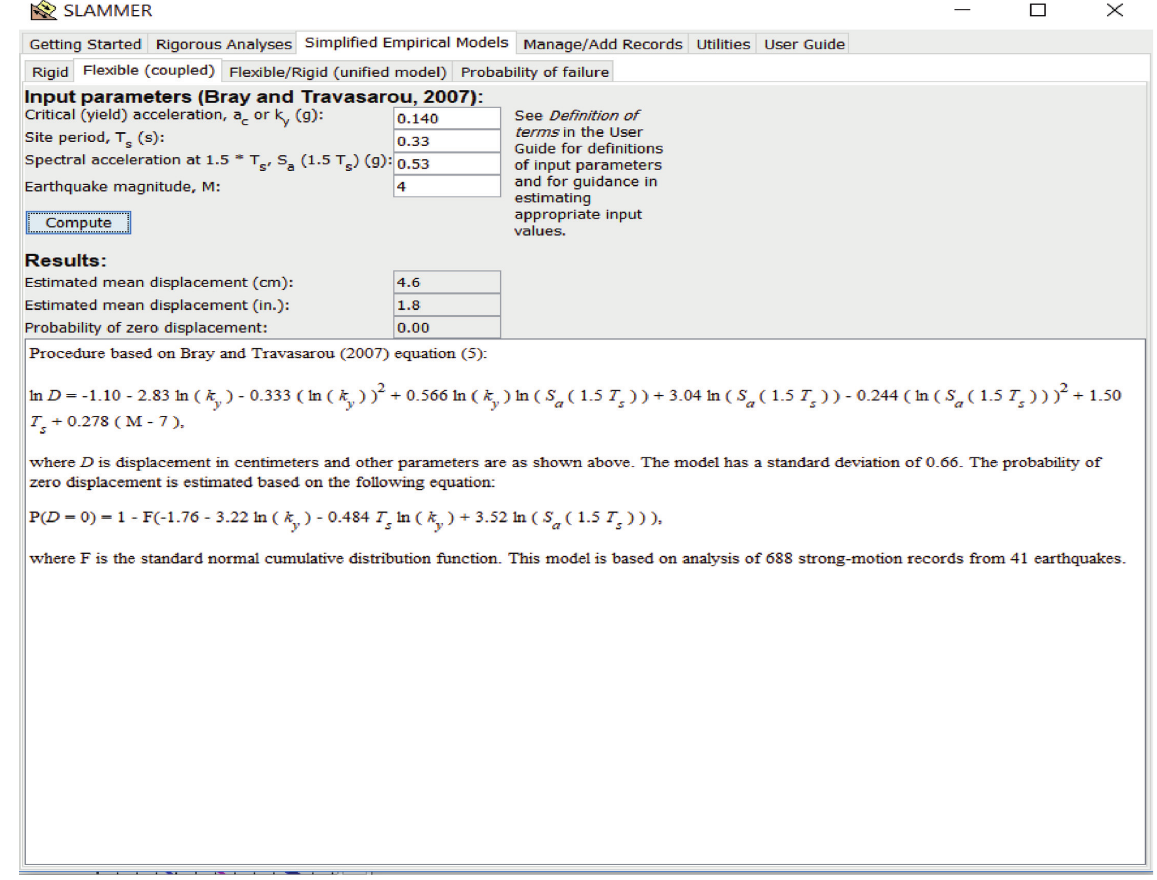
Figure 4: Bray and Travasarou [32] displacement analysis from SLAMMER.